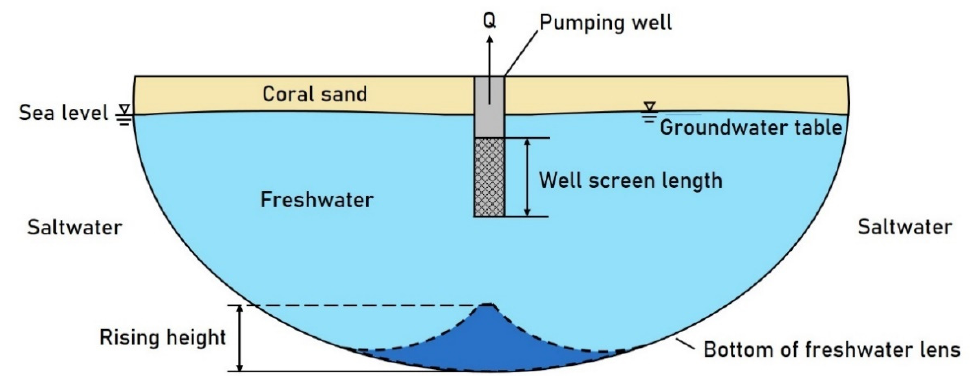
Figure 3. Schematic diagram of the saltwater up-coning process.